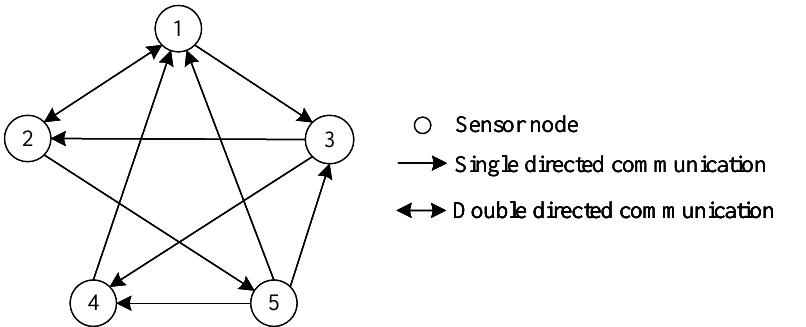
Figure 1. Topology structure of sensor network with five sensors. (authors’ own